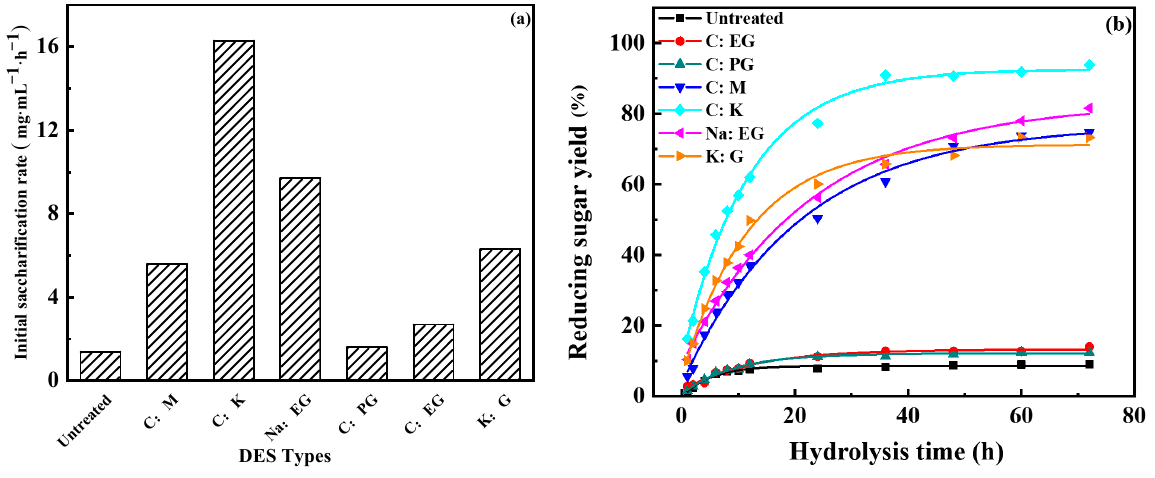
Figure 3. E ff ect of DES type on enzyme hydrolysis: ( a ) initial sacchari fi cation rate, ( b ) reducing Figure 3. Effect of DES type on enzyme hydrolysis: ( a ) initial saccharification rate, ( b ) reducing sugar yield. sugar